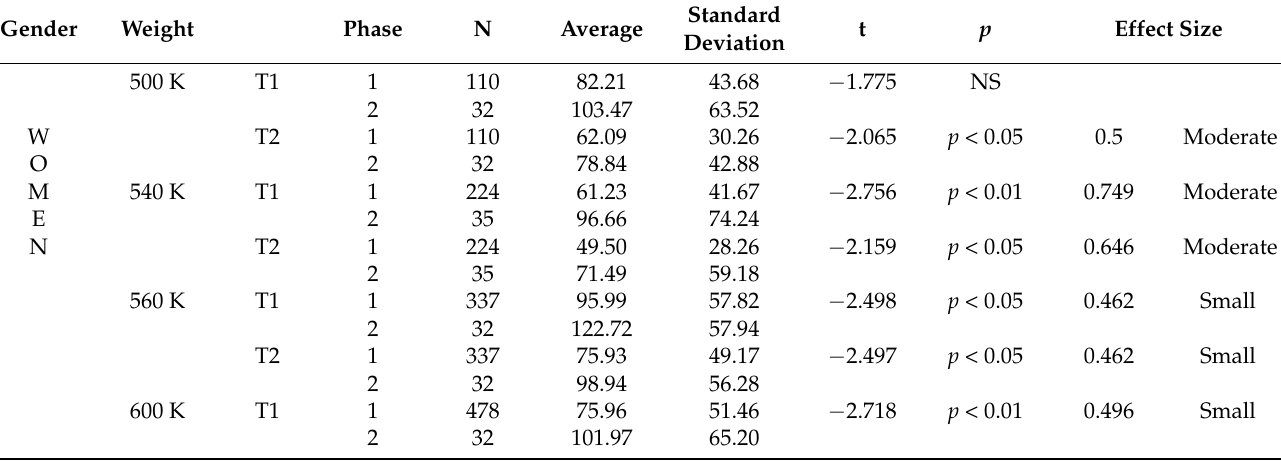
Table 4. Results of comparative analysis of pull durations (T1 and T2) in phase 1 and phase 2 by weight.